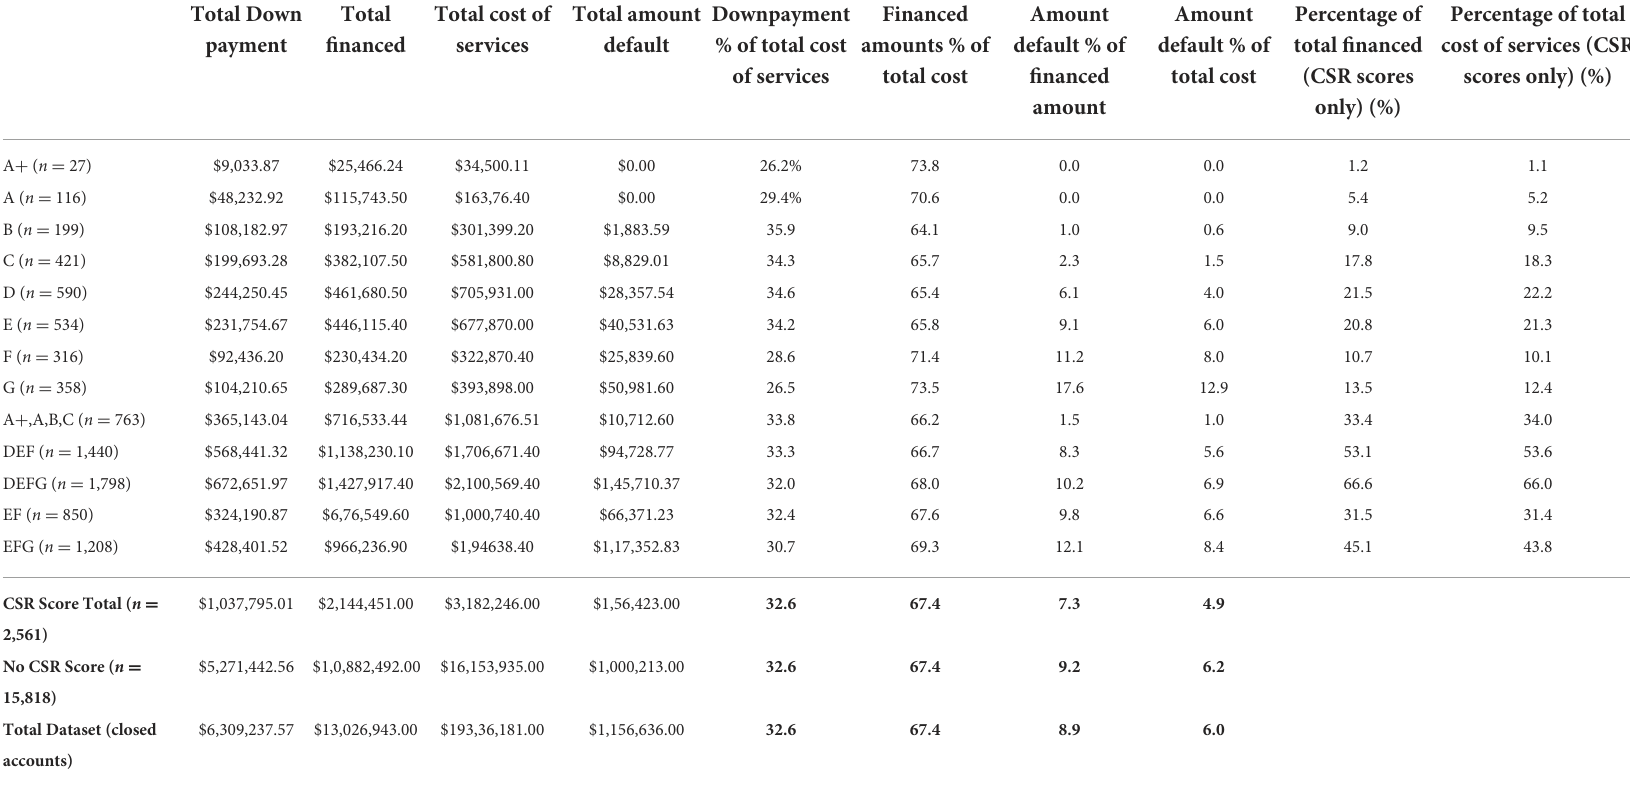
TABLE 4 Default by CSR